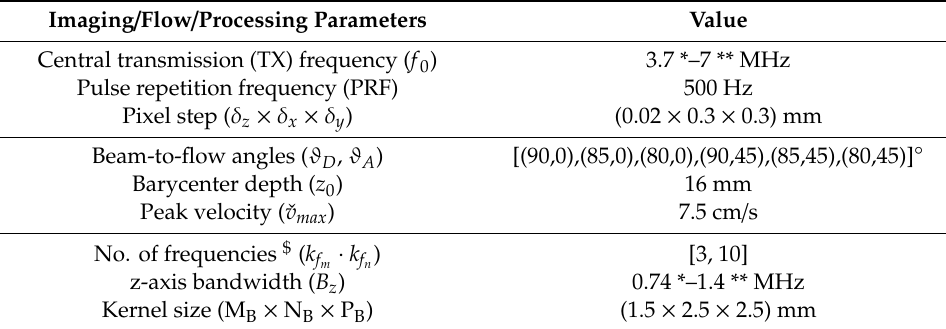
Table 1. Imaging, flow, and processing parameters.